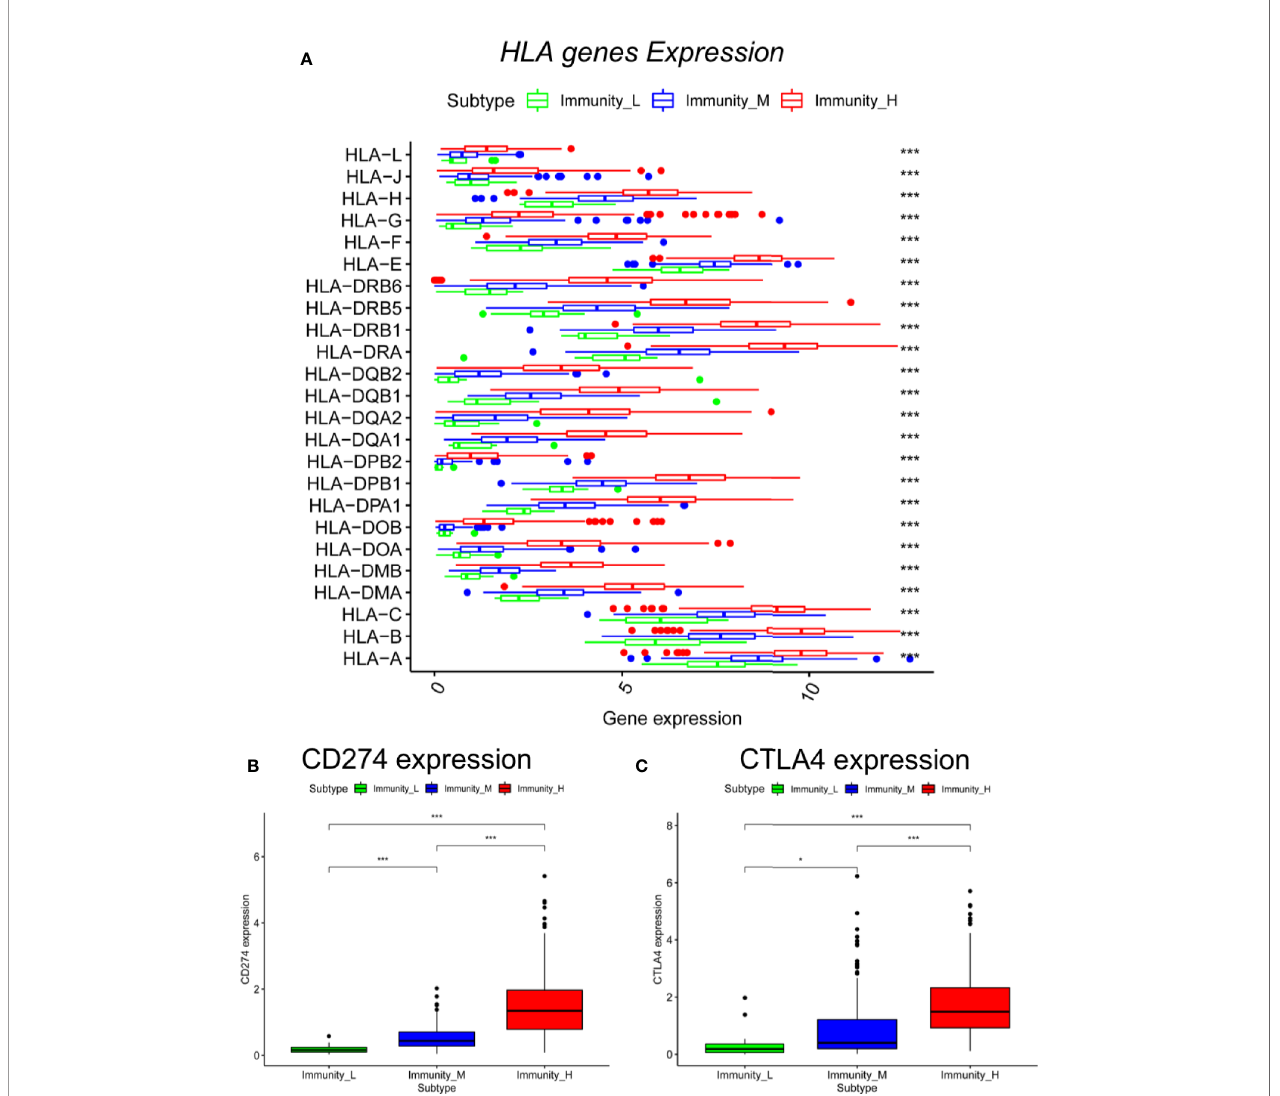
FIGURE 3 | Comparison of HLA genes and immune checkpoint genes between cutaneous melanoma subtypes. Comparison of (A) HLA genes (ANOVA test), (B) CD274, and (C) CTLA4 between three subtypes (Mann – Whitney U test). * P < 0.05, *** P <